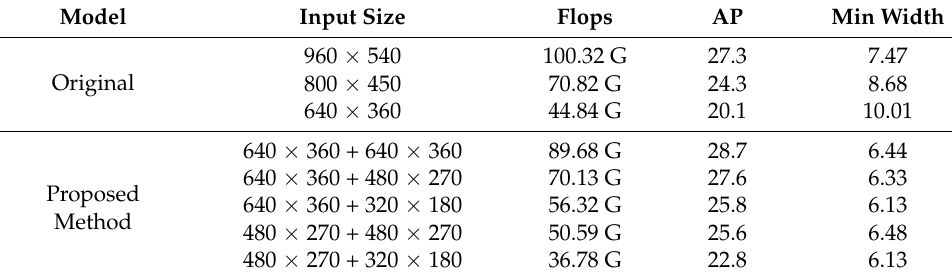
Table 9. Further Improved Methods Evaluation